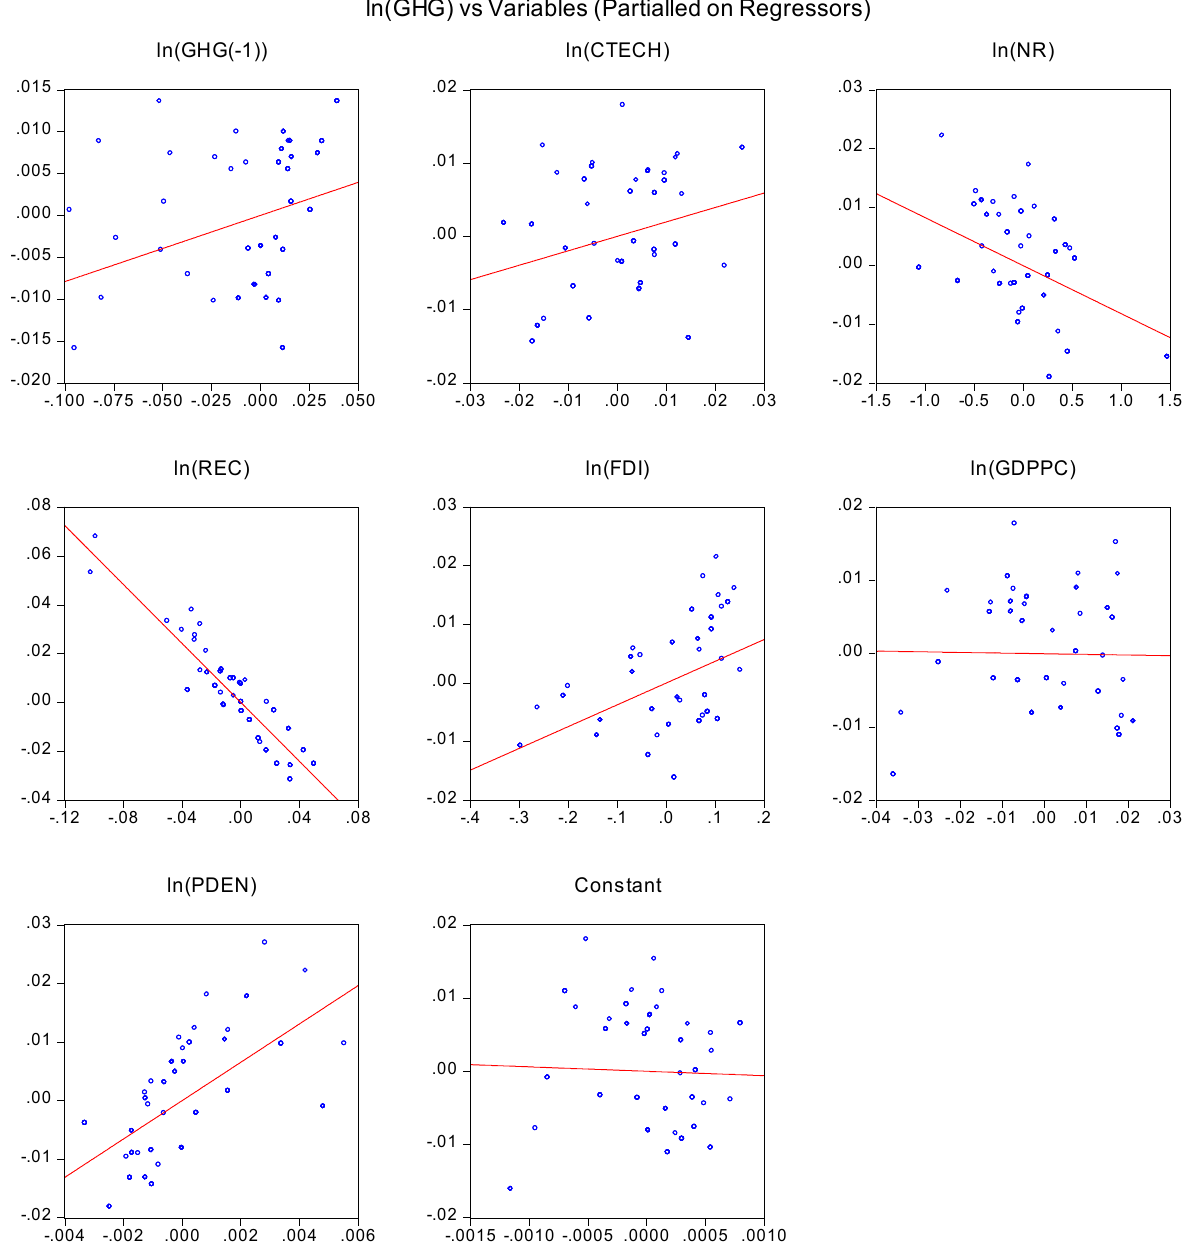
Figure 1. Leverage Plots. Note: GHG shows GHG emissions, CTECH shows clean technologies, REC shows renewal energy consumption, NR shows natural resources, FDI shows inbound FDI, GDPPC shows GDP per capita, and PDEN shows population density.Small bracket shows probability value. Red lines show true lines while blue dots show observation plots. Source: Author’s estimate.